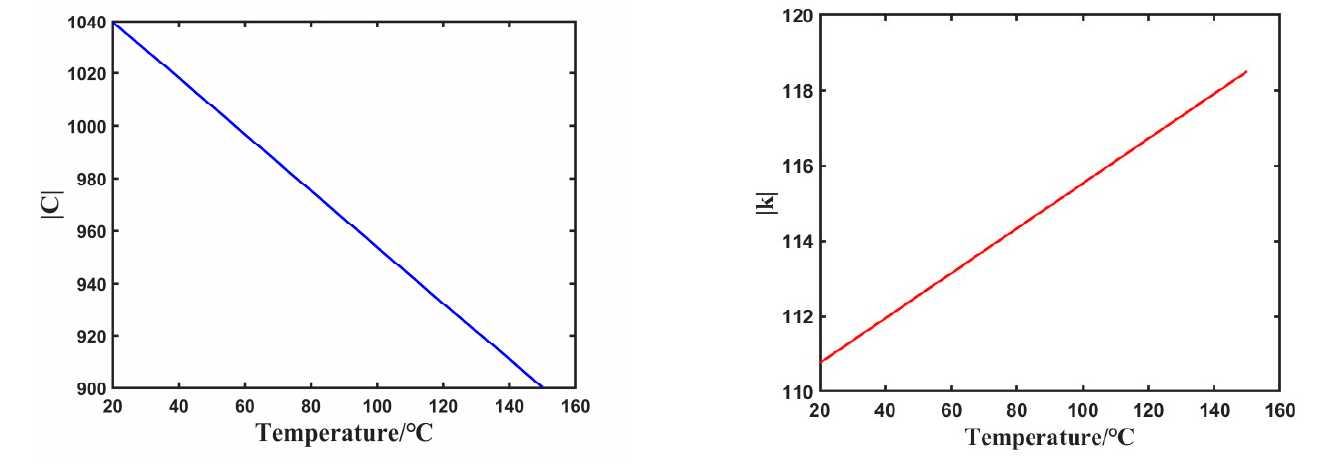
Figure 23. Distribution of S–N slope and intercept at different temperatures.